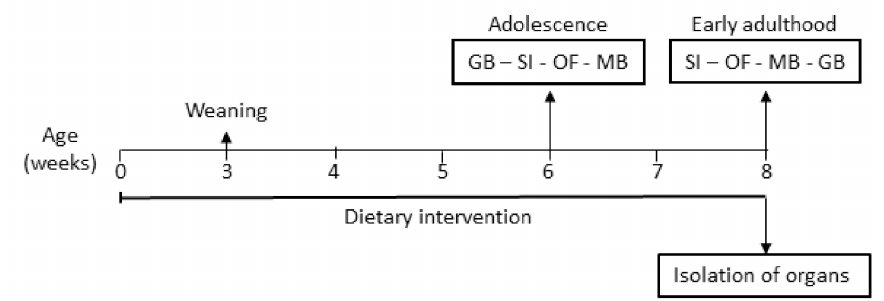
Figure 1. Schematic overview of the experimental protocol and the executed behavioural tests. From day of birth, the dams received a control diet, a 3% scGOS:lcFOS (9:1)-enriched diet, a n-3 PUFA diet or a combination diet containing 3% scGOS:lcFOS and n-3 PUFAs. The pups were weaned